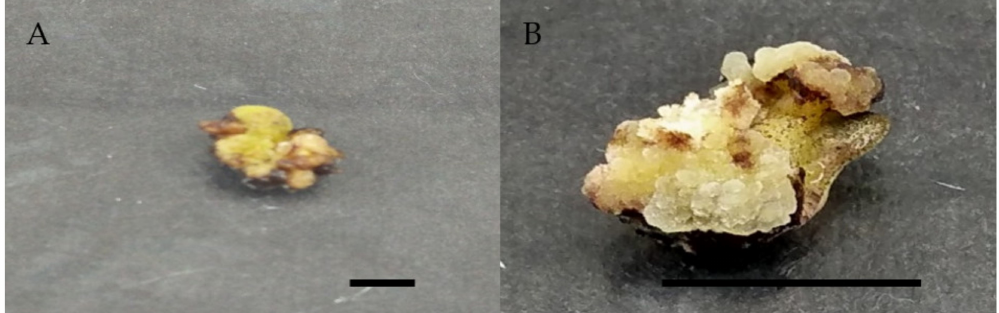
Figure 2. Callus induction of Labisia pumila var. alata on MS medium with single concentration of 2,4-D and picloram after 4 weeks of culture. ( A ) 0.5 mg/L 2,4-D and ( B ) 1.0 mg/L picloram. Horizontal bar = 1